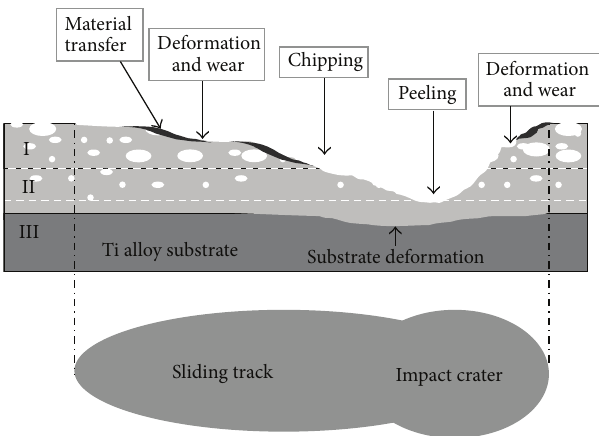
Figure 7: A diagram of the coating failure behavior of the inclined impact sliding test [16].